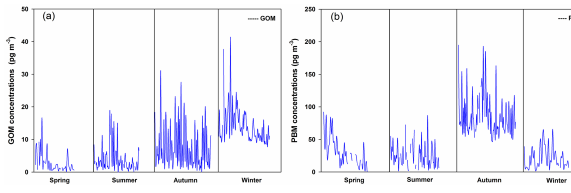
Figure 6. Seasonal variability in GOM and PBM during four sam- pling